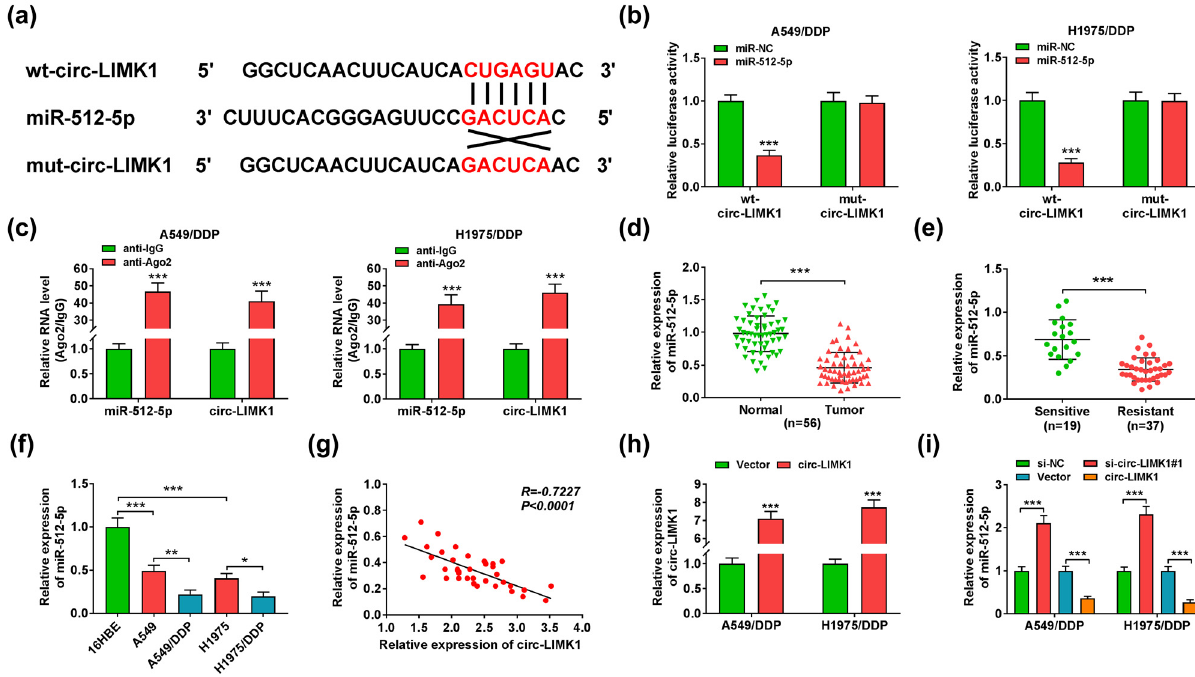
Figure 3: circ - LIMK1 could target miR - 512 - 5p in lung adenocarcinoma DDP - resistant cells. ( a ) Circular RNA interactome predicted the targeted binding sites of miR - 512 - 5p and circ - LIMK1. ( b ) The luciferase activities of wt - circ - LIMK1 or mut - circ - LIMK1 were analyzed by dual - luciferase reporter assay in A549/DDP and H1975/DDP cells after transfected with miR - NC or miR - 512 - 5p. ( c ) The target relationship between miR - 512 - 5p and circ - LIMK1was measured by RIP assay. ( d ) RT - qPCR was performed to test the expression of miR - 512 - 5p in normal tissues and tumor tissues. ( e ) The expression of miR - 512 - 5p in sensitive tumor tissues and resistant tumor tissues was detected by RT - qPCR. ( f ) RT - qPCR was employed to measure the expression of miR - 512 - 5p in 16HBE, A549, A549/DDP, H1975, and H1975/DDP cells. ( g ) Pearson correlation analysis was used to detect the correlation between miR - 512 - 5p and circ - LIMK1. ( h ) RT - qPCR was performed to measure the expression of circ - LIMK1 in A549/DDP and H1975/DDP cells after transfected with vector or circ - LIMK1. ( i ) RT - qPCR was employed to test the expression of circ - LIMK1 in A549/DDP and H1975/DDP cells after transfected with si - NC, si - circ - LIMK1#1, vector, or circ - LIMK1. * P < 0.05, ** P < 0.01, *** P <